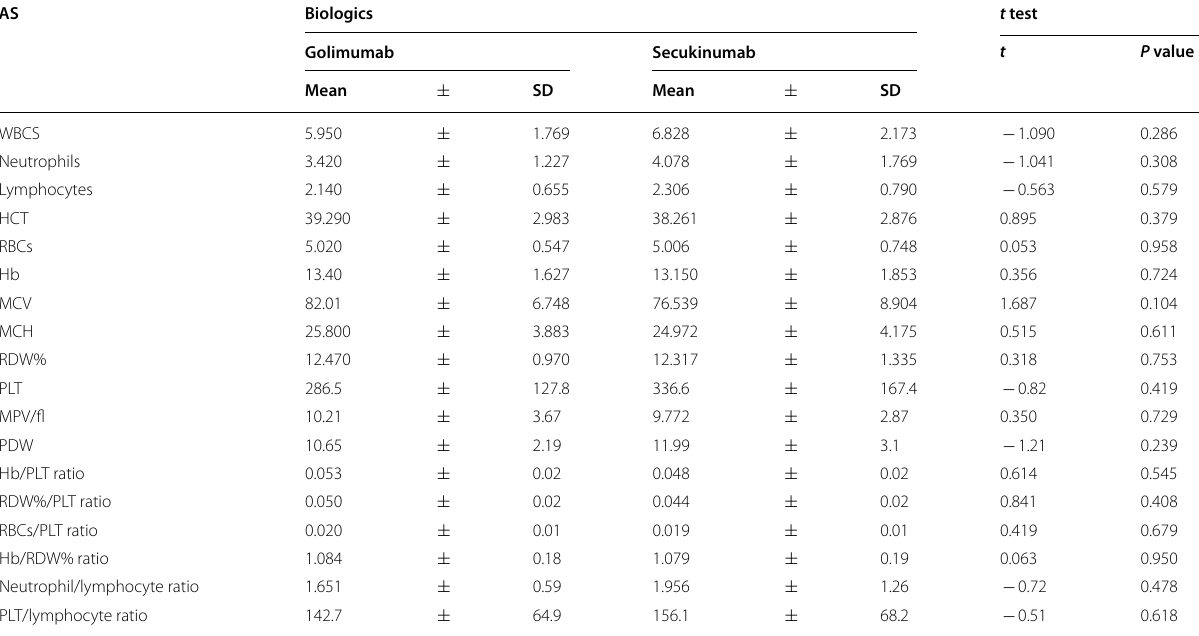
Table 6 Comparison between different types of biologics in AS as regards WBCs, RBCs, and platelets